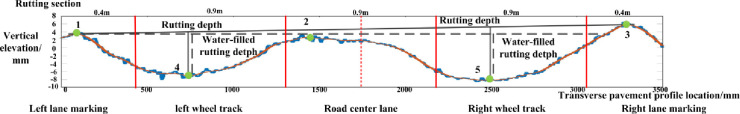
Schematic diagram for the calculation of rut parameters and rut section.